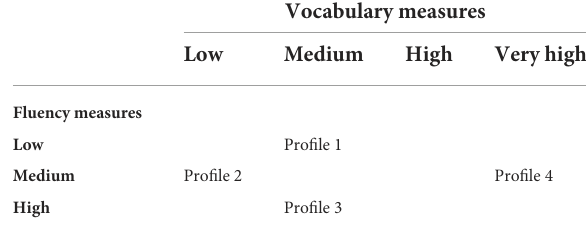
TABLE 9 Distribution of fluency and vocabulary measures for each profile.